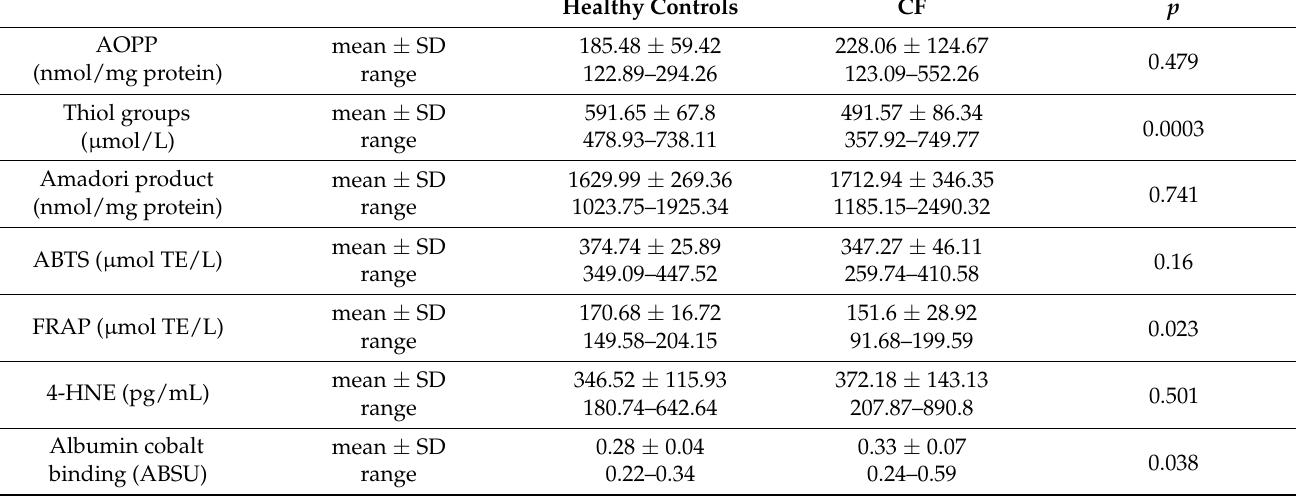
Table 2. Markers of oxidative stress in controls and participants with CF a . Healthy Controls